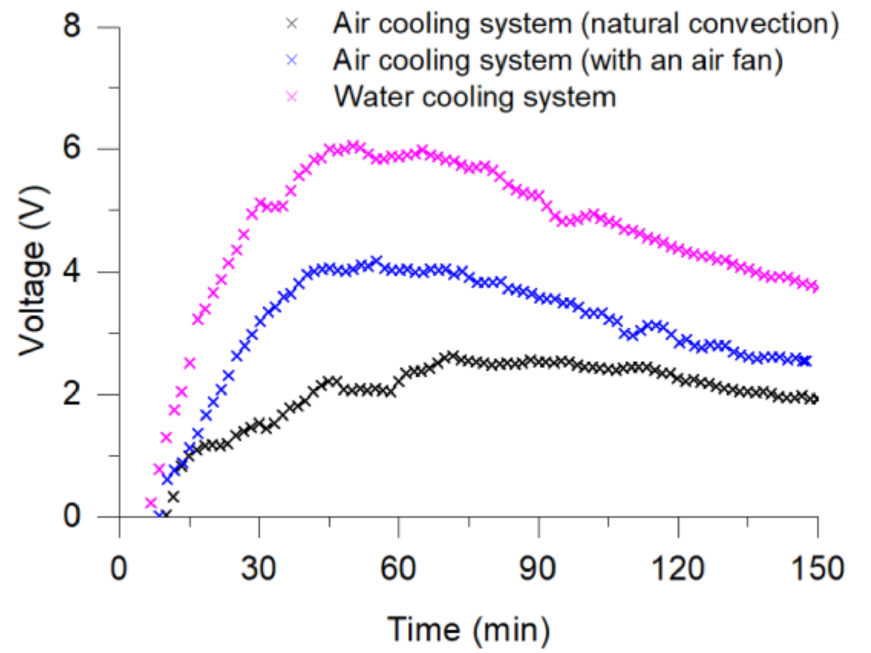
Figure 11. Variations in the TEG output voltage during the combustion process depending on the cooling method (when TEG No. 4 was